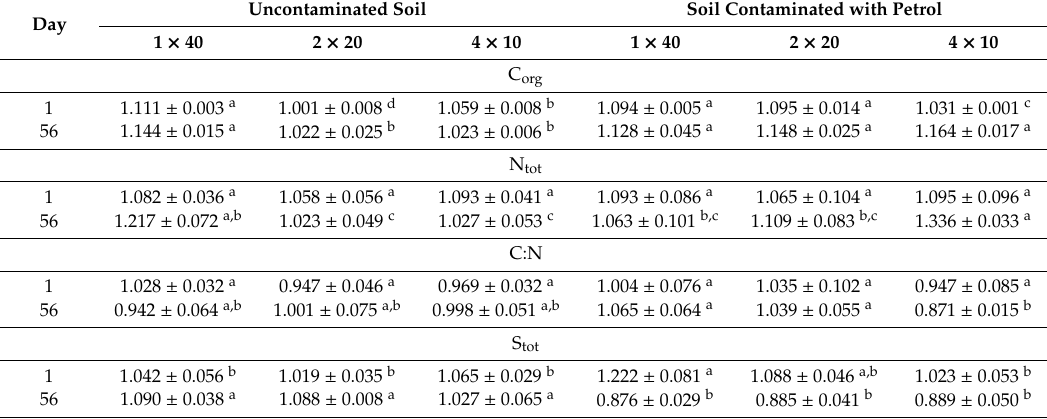
Table 3. Indices of Fyre-Zyme e ff ect ( IF FZ ) on chemical parameters in soil uncontaminated and contaminated with